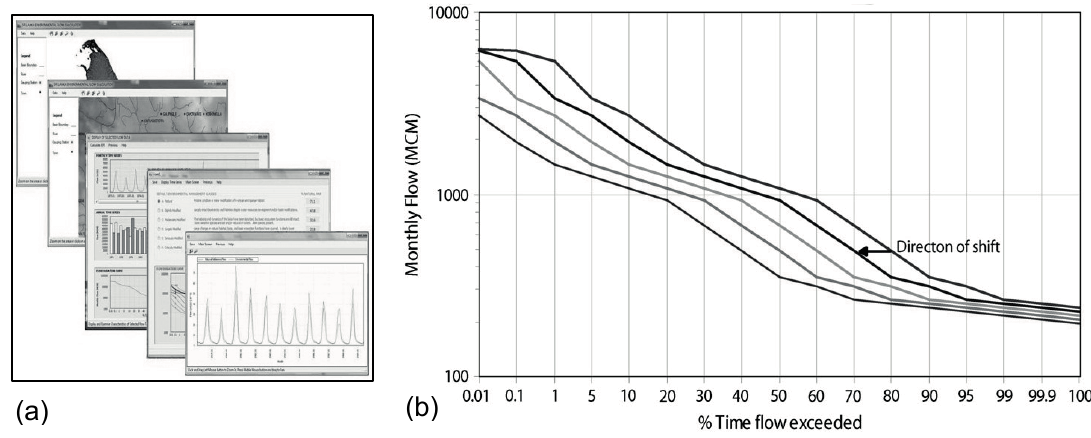
Fig. 1 (a) Screenshots of the software and (b) natural and environmental